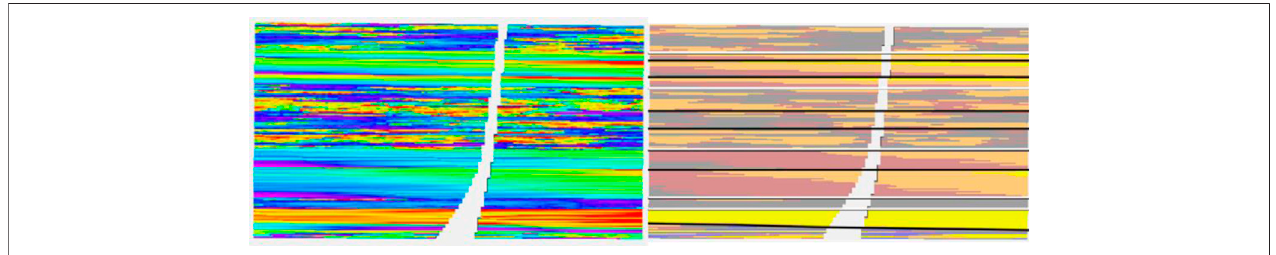
FIGURE 3 | Cross section of the reservoir. The facies used for model construction are shown on the right, although these are not used in subsequent modeling effort.